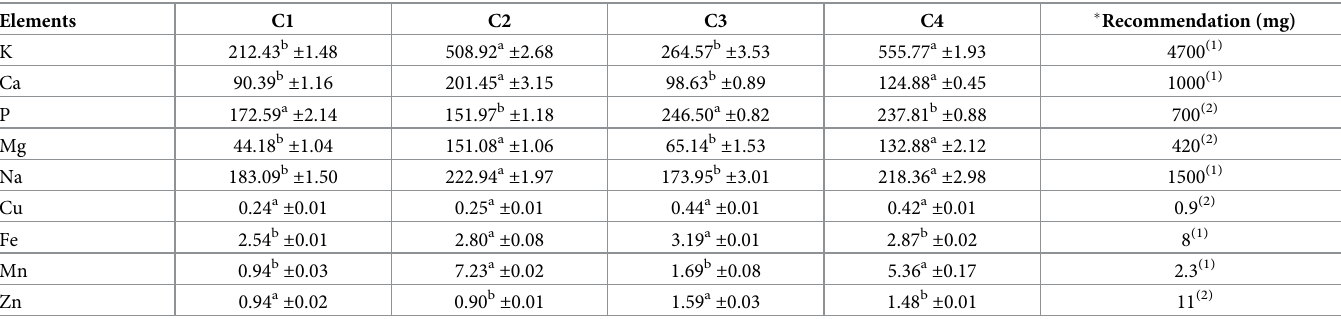
Table 3. Minerals profile in mg/100 g of